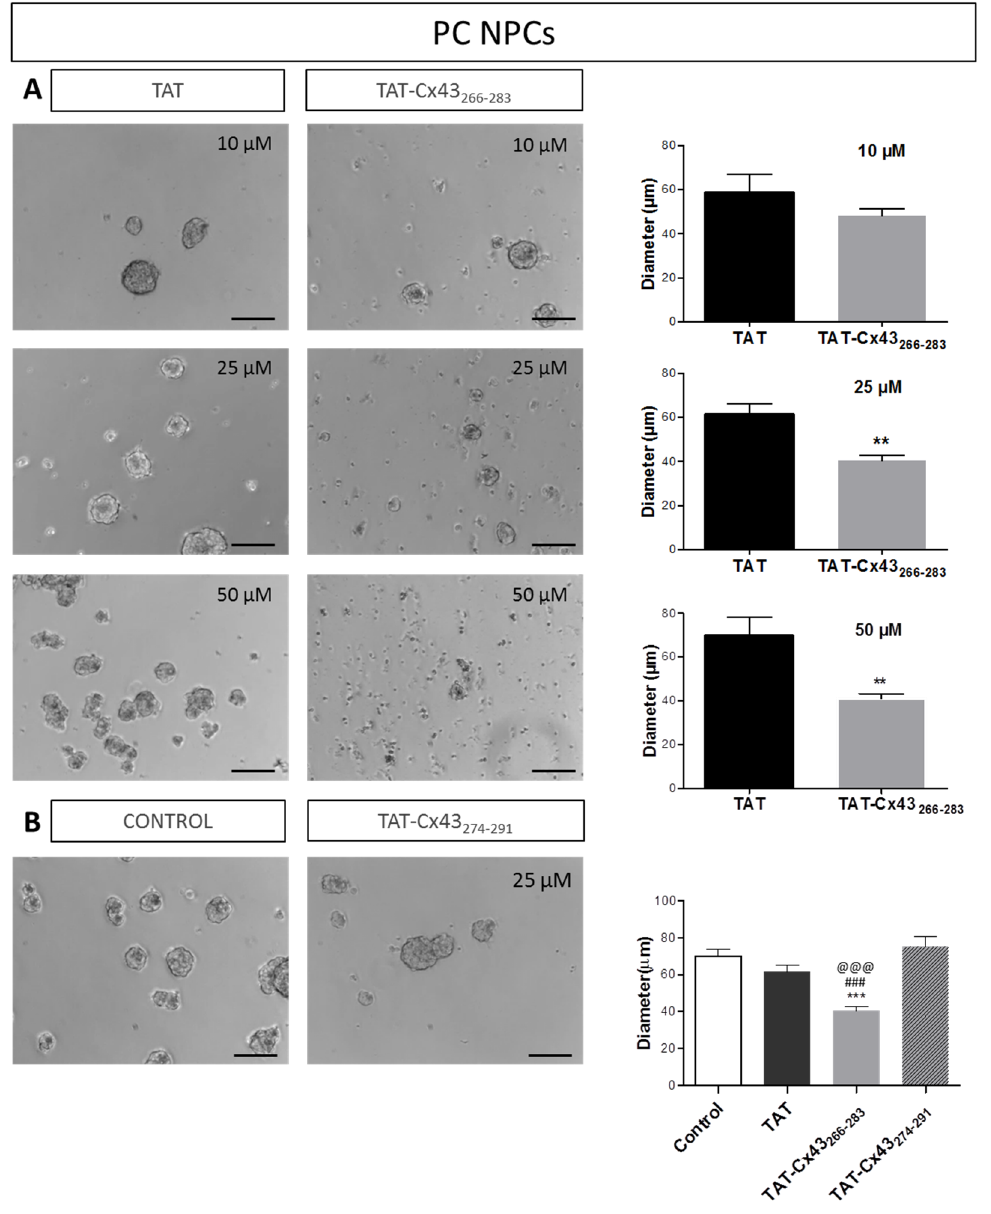
Figure 2. E ff ect of TAT-Cx43 266–283 on neurosphere size in proliferation conditions. ( A ) Phase-contrast images of neural progenitor cells grown in proliferation conditions (PC NPCs) after treatment with 10, 25, or 50 µ M of TAT or TAT-Cx43 266–283 for 72 h. Bar: 100 µ m. Quantification of neurosphere diameter after 72 h treatment with 10–50 µ M of TAT or TAT-Cx43 266–283 . Data are the mean ± SEM of n = 6–7 (** p < 0.01, Mann–Whitney Rank Sum Test). ( B ) Phase-contrast images of PC NPCs untreated (control) or treated with 25 µ M control peptide, TAT-Cx43 274–291 , for 72 h. Bar: 100 µ m. Quantification of neurosphere diameter in untreated cultures (control) or cultures treated with 25 µ M TAT, 25 µ M TAT-Cx43 266–283 , or 25 µ M TAT-Cx43 274–291 for 72 h. Data are the mean ± SEM, n = 12 (control), n = 9 (TAT), n = 7 (TAT-Cx43 266–283 ), n = 4 (TAT-Cx43 274–291 ) (*** p < 0.001 vs. control; ### p < 0.001 vs. TAT; @@@